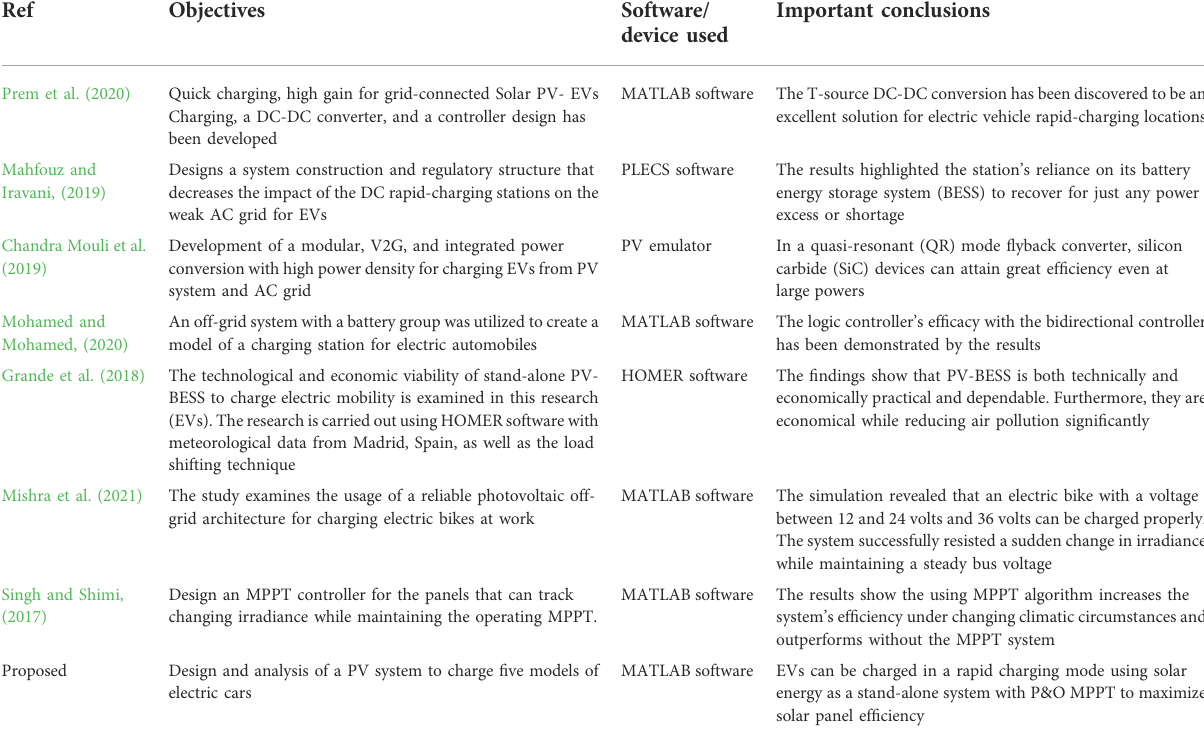
TABLE 1 A review of the literature based on the charging of electric